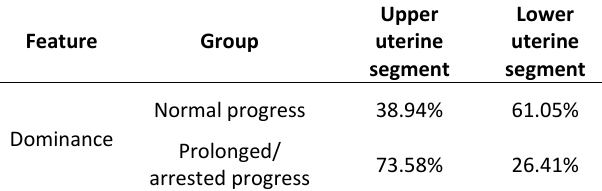
Fig. 4: The transition patterns of contractions between the states represented in percentage The dominant regions of the uterus during regions 2 to 4 of a contraction is represented in table 6. There is a noticeable difference in the dominant regions of the uterine segments. In prolonged progress cases, around three-fourth of the contractions were dominant in the upper uterine segment, whereas in the normal progress group, around three-fifths of the contractions were dominant in the lower uterine segment. Table 6. Dominant region of the uterus during